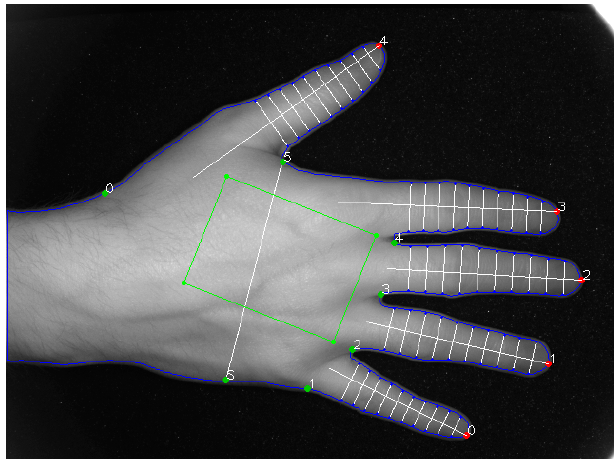
Figure 3. Depiction of all measured characteristics of an object (the human hand).